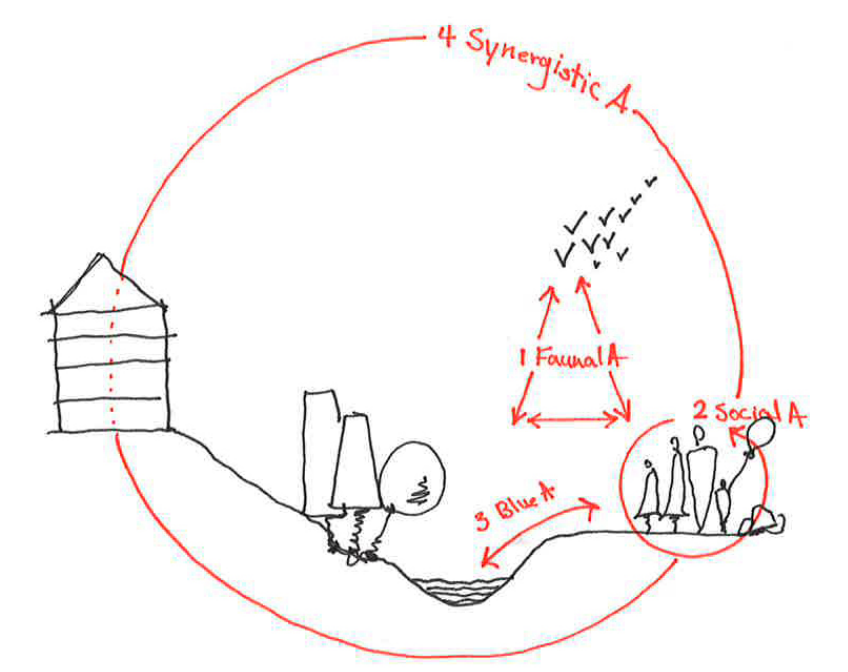
Figure 3. Four kinds of Affordance around blue-green solutions in Augustenborg, Malmö. Notes: 1) Faunal affordance, related to nonhuman animals; 2) social affordance, related to the presence of other people; 3) blue affordance, related to water; and 4) synergistic affordance, related to synergy. These affordances were identified from respondents’ comments, and we focused especially on the affordances that cannot easily be applied to green spaces without blue-green solutions. Source: Misagh